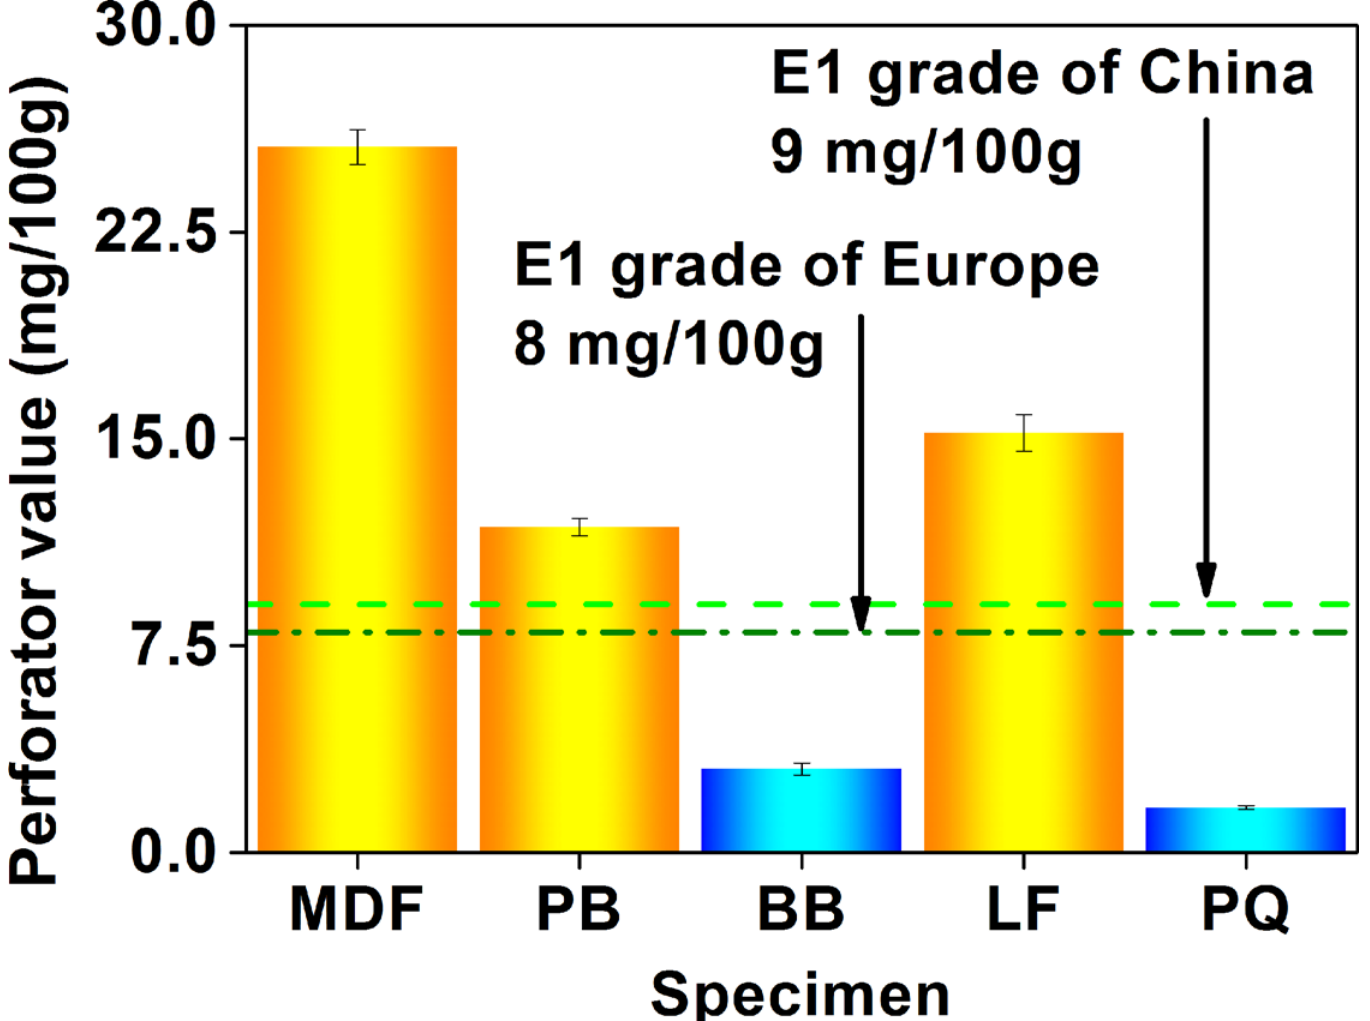
Fig 2. Formaldehyde emission values (perforator value) of various materials characterized by the perforator extraction method of the Chinese national standard GB 18580. MDF, medium density fiberboard; PB, particleboard; BB, blockboard; LF, laminate flooring; PQ,